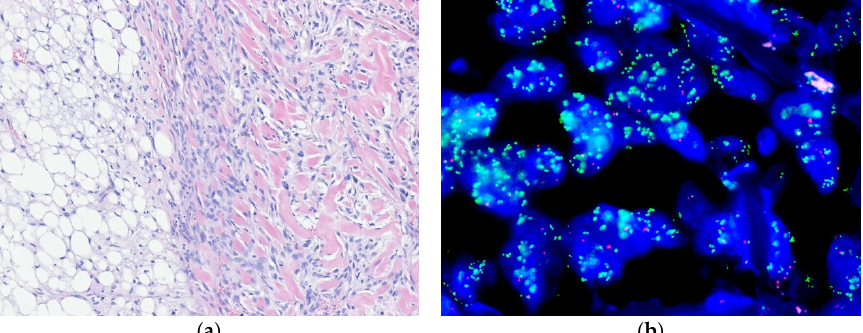
Figure 2. Dedifferentiated liposarcoma. ( a ) The tumor shows an abrupt transition from well-differentiated liposarcoma component to a non-lipogenic, high-grade dedifferentiated area (right). ( b ) The dedifferentiated component shows MDM2 amplification by FISH. The green signal corresponds to the MDM2 probe, while the red signal corresponds to the chromosome 12 centromeric probe (H&E stain, original magnification 100 × a ; MDM2 FISH, original magnification 1000 × b